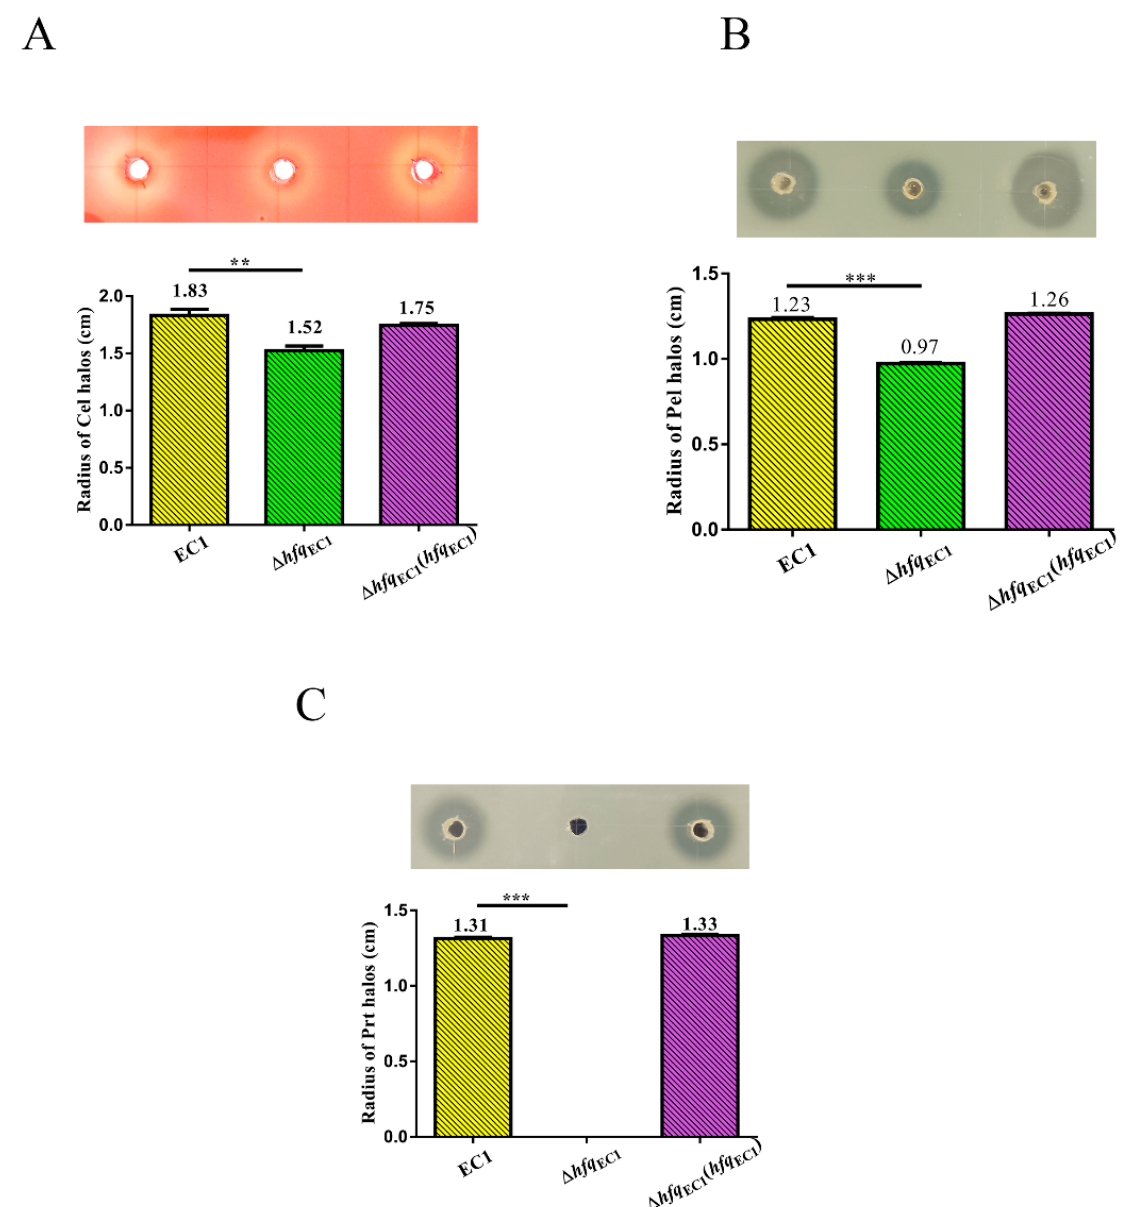
Figure 2. Hfq EC1 regulates the production of cell wall–degrading enzymes. The wild-type strain EC1 of Dickeya oryzae and its derivatives were cultured in Luria–Bertani (LB) medium to an OD 600 of 1.5. Production of Cel ( A ), Pel ( B ), and Prt ( C ) was measured in the media with their substrates and the corresponding methods. For semi-quantification of enzyme production, the radius of each halo was measured. Experiments were individually performed at least three times in triplicate. The data shown are the means ± SE ( n = 3). ** p < 0.05; *** p < 0.01. 3.3. Hfq EC1 Contributes to Swarming Motility and Biofilm Formation in D. oryzae